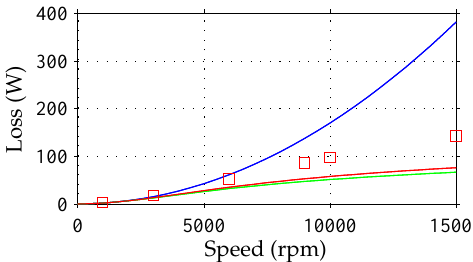
Figure 7. Predicted losses per magnet segment P m as function of rotor speed and for magnet lengths l m = 60 mm in V-shaped interior PMs ( w m = 30 mm) for Model A (blue lines), Model A but compensated as P m / ( ε A B + 1 ) (dashed blue line), Model B (red line), Model C (green line), and | corresponding 3D-FEM results (circles “ "). ◦